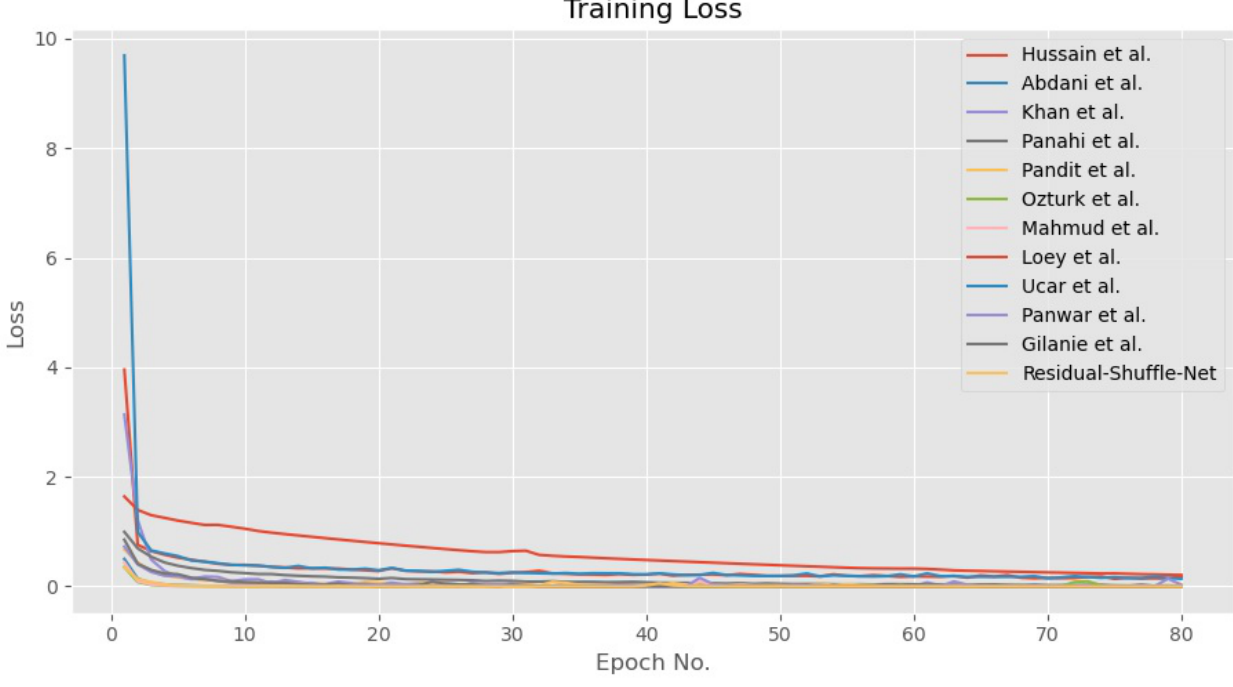
Figure 6. Training loss for Residual-Shuffle-Net and all of its benchmark